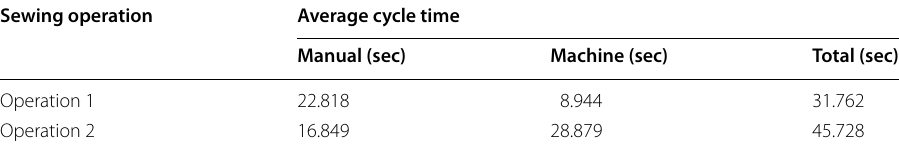
Table 1 Average cycle time of two sewing operations Sewing